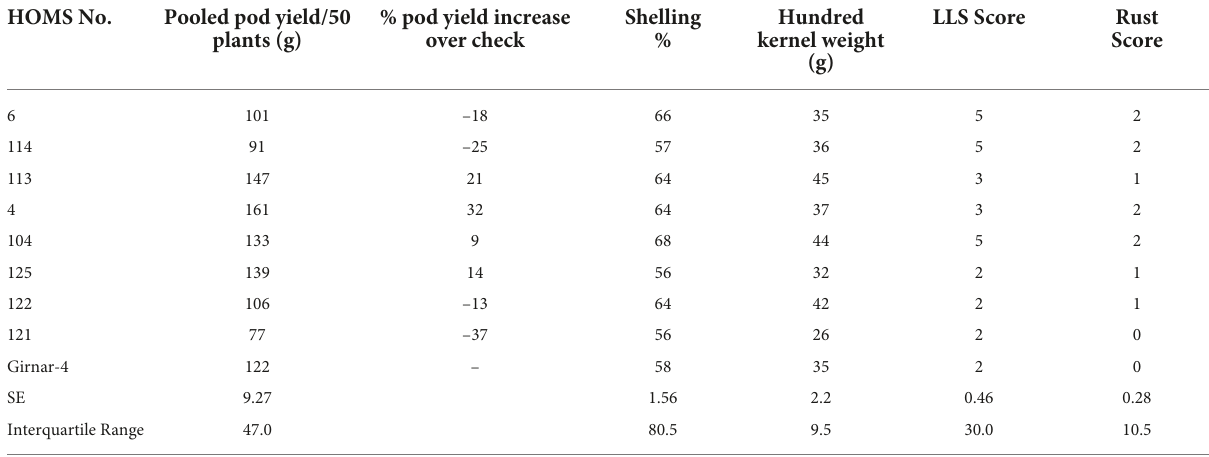
TABLE 4 Pod yield of Virginia bunch (VB) high oleic breeding lines, percent increase of pod yield over check, shelling% and hundred kernels weight in the rainy season. HOMS